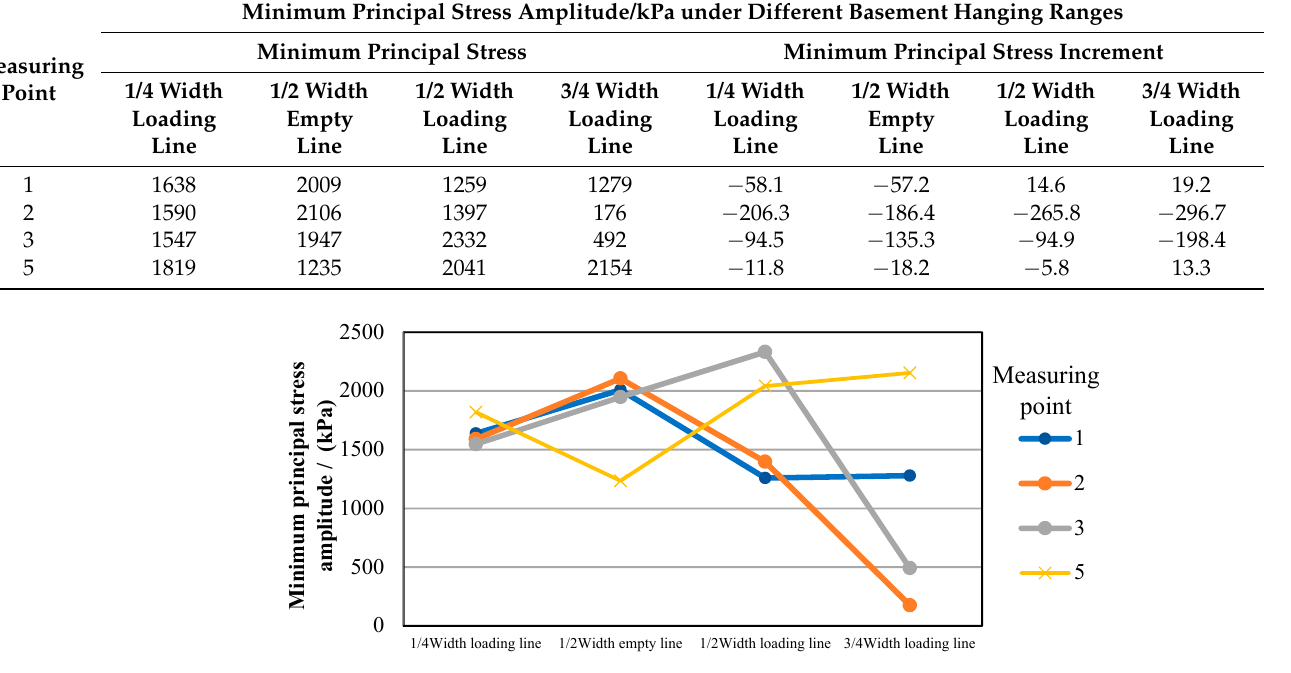
Table 16. Minimum principal stress amplitude of measuring points 1, 2, 3, and 5 under different basement hanging ranges. Measuring